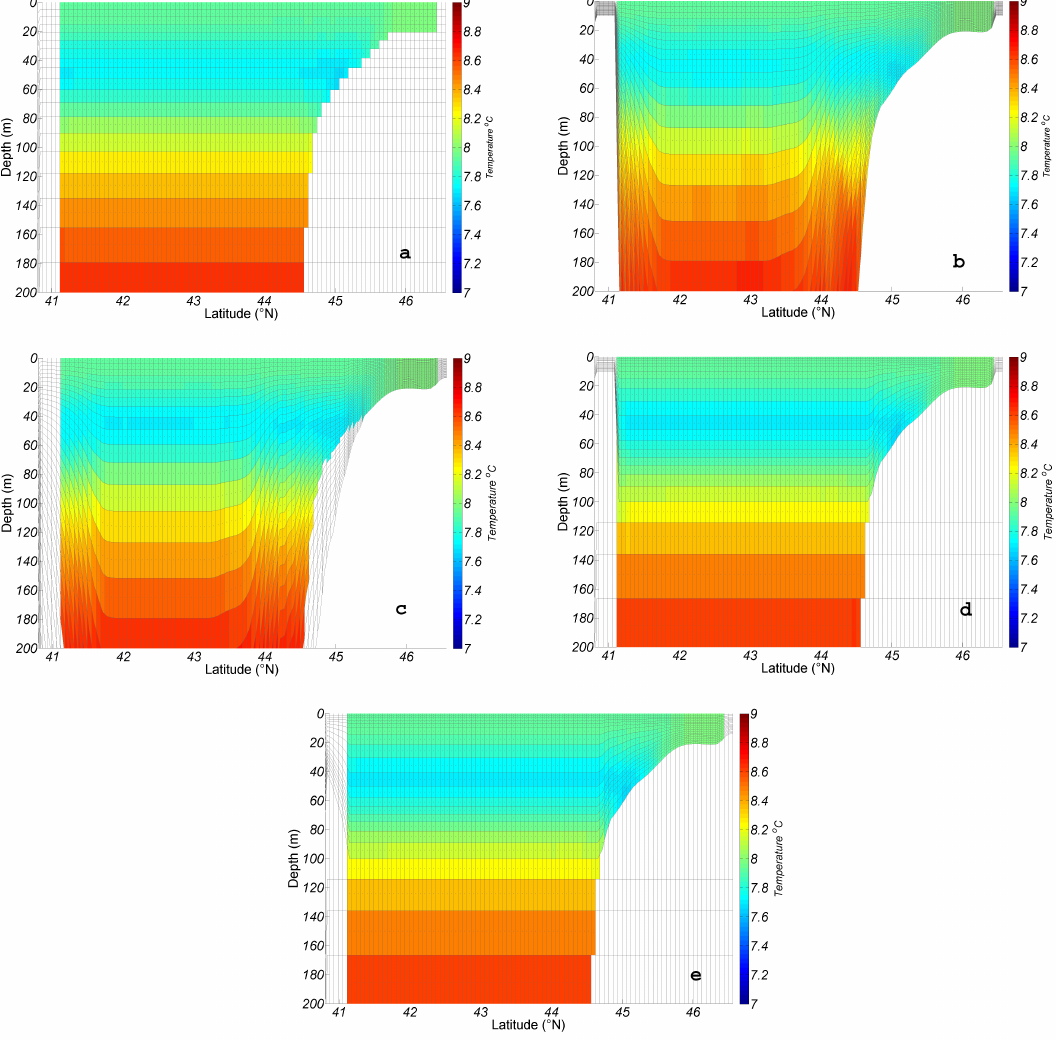
Fig. 6. Zonal velocity distribution along 43.3 ◦ N after 1month of simulation of the conical front: (a) ZCO; (b) SCO; (c) Z*SIG; (d) SZH; (e) SZHENV. (f) initial temperature transect is shown only for ZCO; other configurations are very